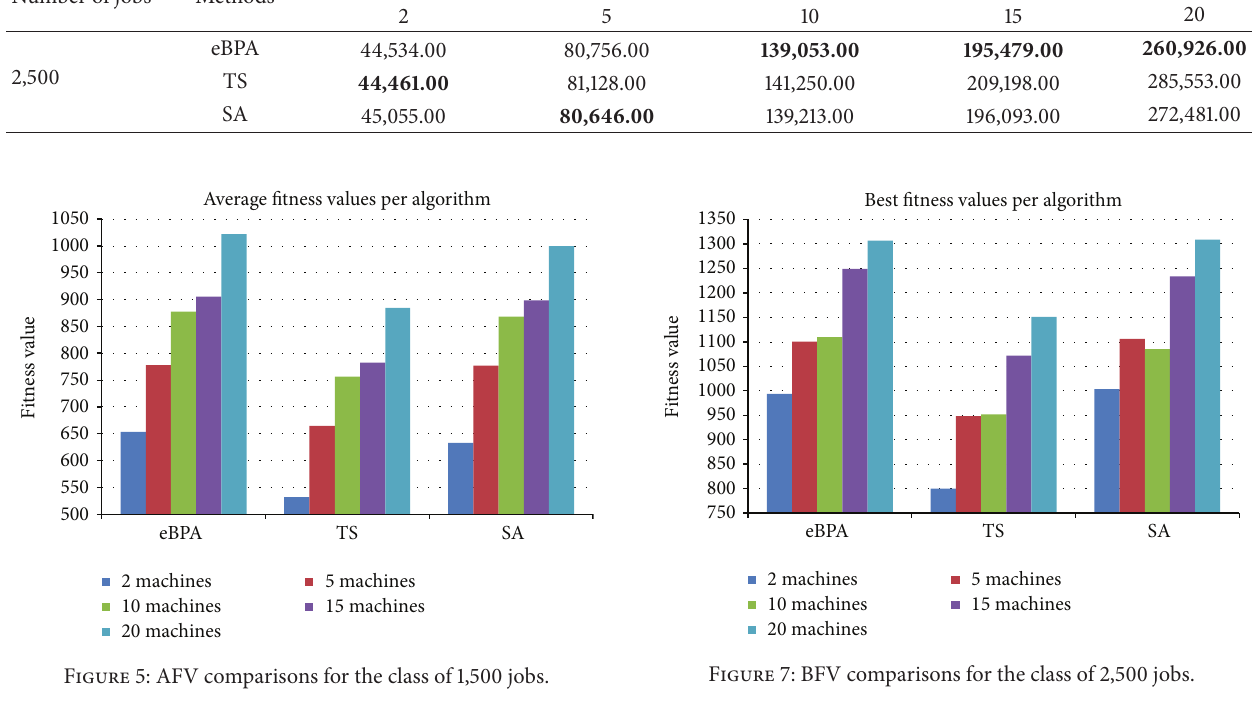
Table 6: The average execution times in milliseconds, per machine set, for the class of 2,500 jobs. Number of jobs